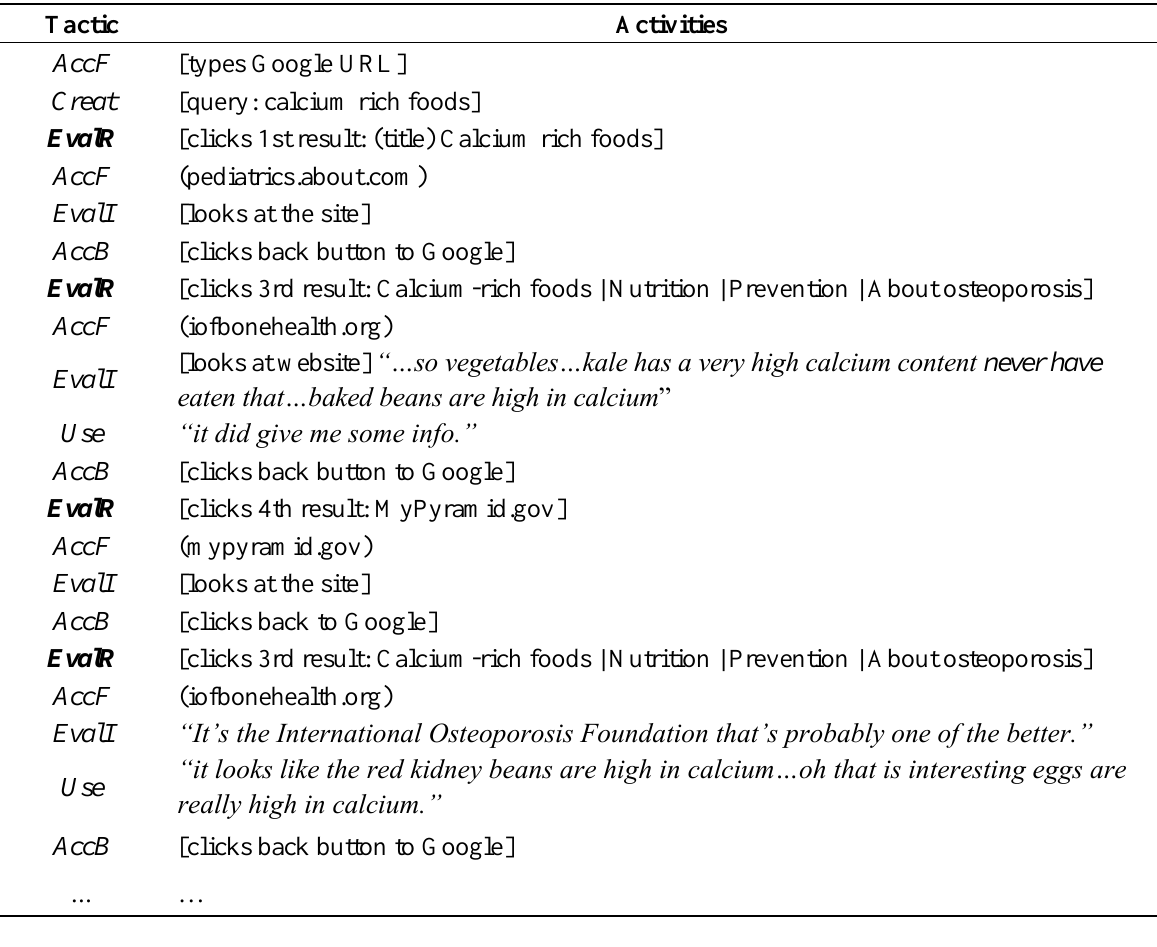
Table 5. Iterative result evaluation